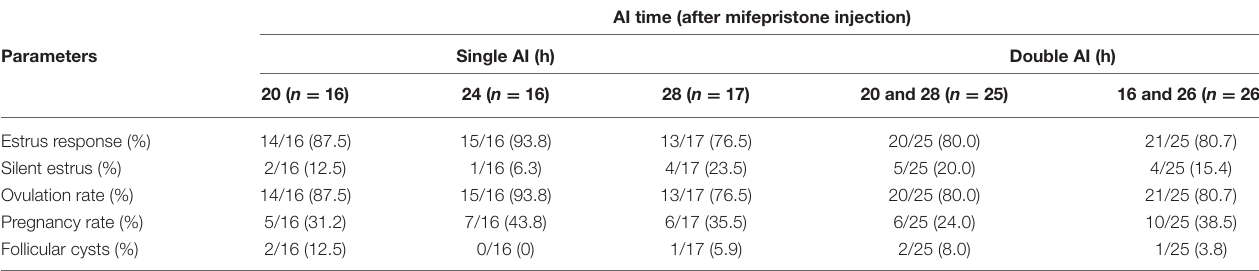
TABLE 4 | Fertility parameters of buffaloes synchronized by GPGMH protocol in connection to different AI times and frequency.